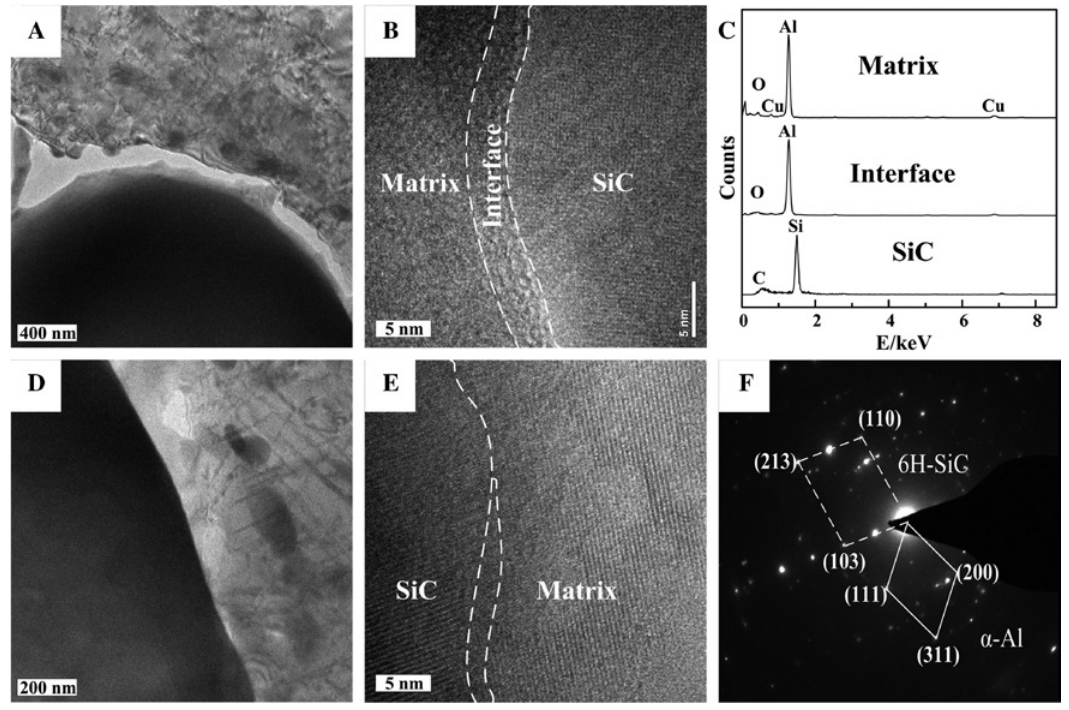
Figure 4: (A) TEM micrograph, (B) HRTEM image, and (C) TEM-EDS spectra of the interface in the composites before extrusion, (D) TEM micrograph and (E) HRTEM image of the interface in the composites after extrusion, and (F) selected area electron diffraction pattern of the SiC